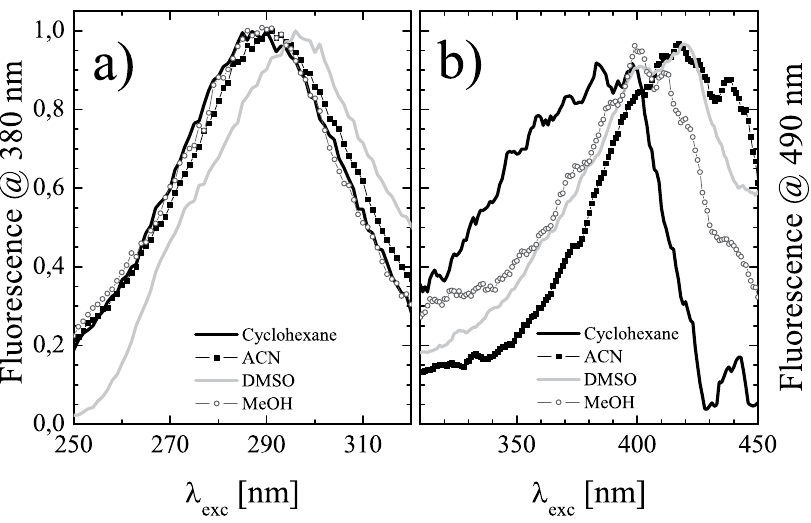
Fig 6. Fluorescence excitation spectra of K2T23. Excitation spectra of K2T23 dissolvedin cyclohexane (line), acetonitrile (squares), dimethylsulfoxide (crosses), and methanol(circles), obtained by monitoringthe fluorescence intensity: a) at λ obs,DK = 380 nm; b) at λ obs,KE = 490 nm.